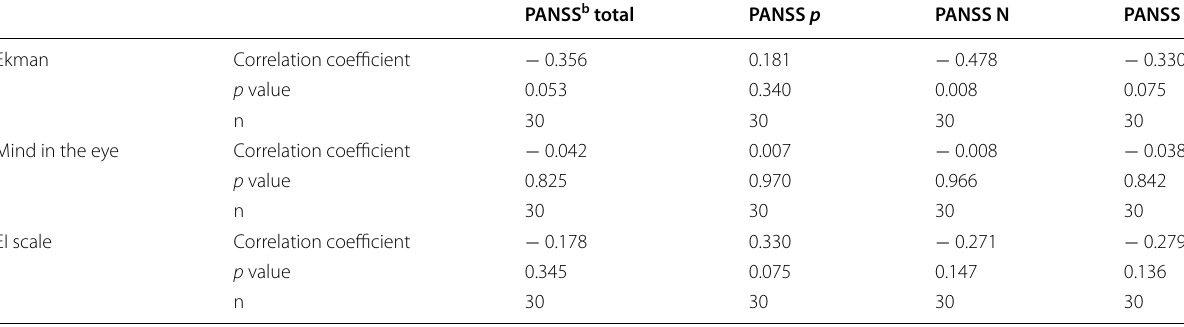
a EI scale: Emotional Intelligence scale. b PANSS: Positive and Negative Syndrome Scale for Schizophrenia